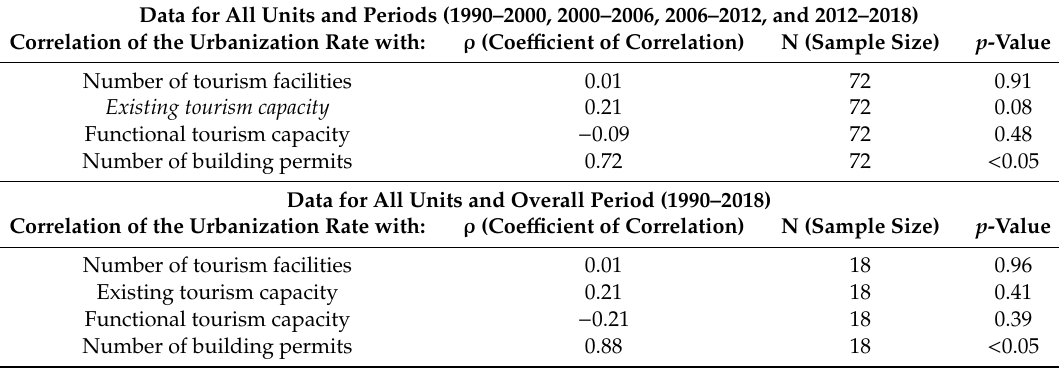
Table 7. Correlation between the urbanization rate and its urban development and tourism-related drivers. Significant predictors ( p ≤ 0.05) are marked using bold font, and marginally significant predictors (0.05 < p ≤ 0.1) using italic font.